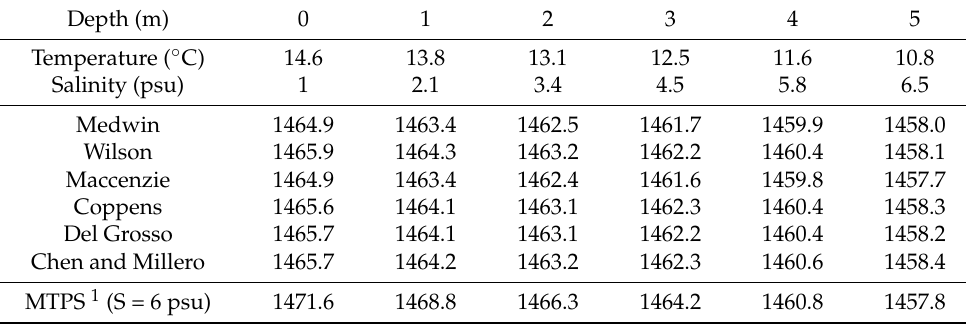
Table 5. Sound speed in water determined using selected